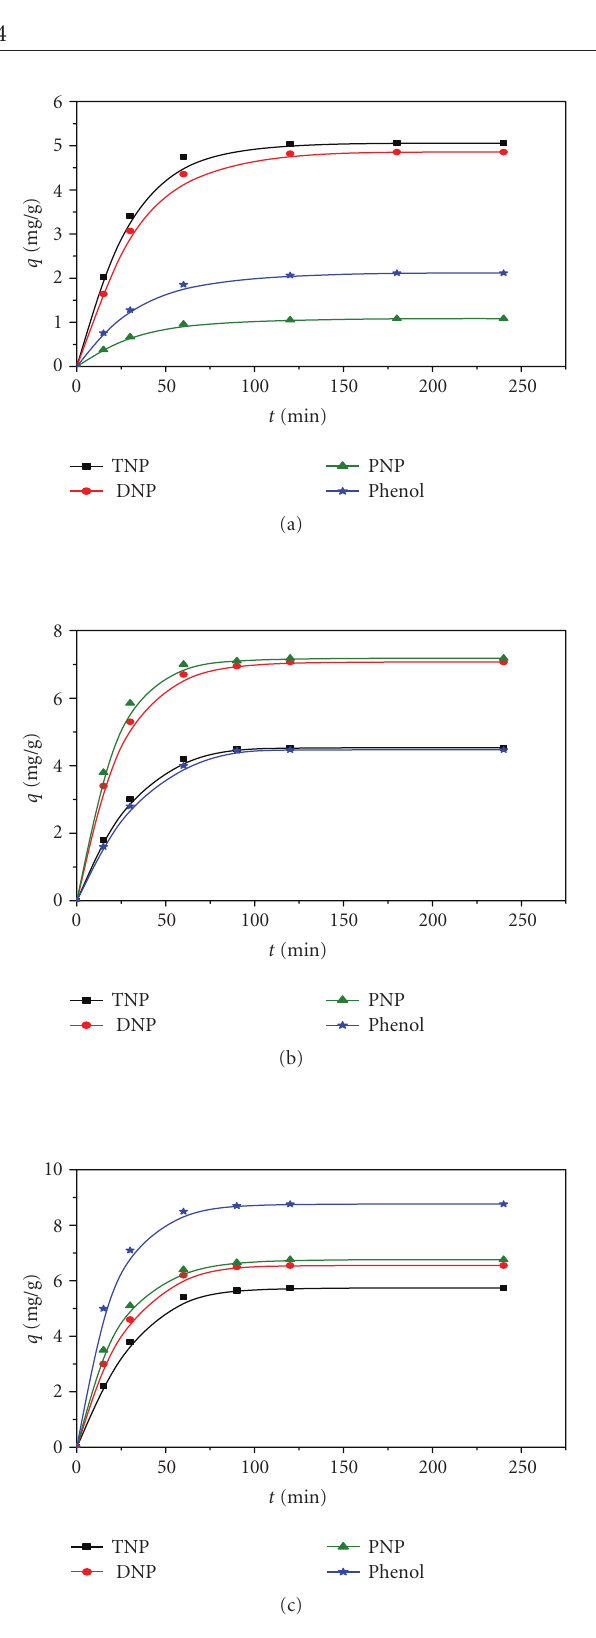
Figure 2: Kinetics of adsorption of phenolic compounds in pres- ence of di ff erent catalysts (a). Degussa P25, (b) Millennium PC- 500, and (c) Millennium PC-500 TiO 2 deposited on Ahlstrom pa- per 1048. Experimental conditions: C 0 = 30mg/L, [P25] = [PC500] = 2.5 g/L, V = 100mL, natural pH.